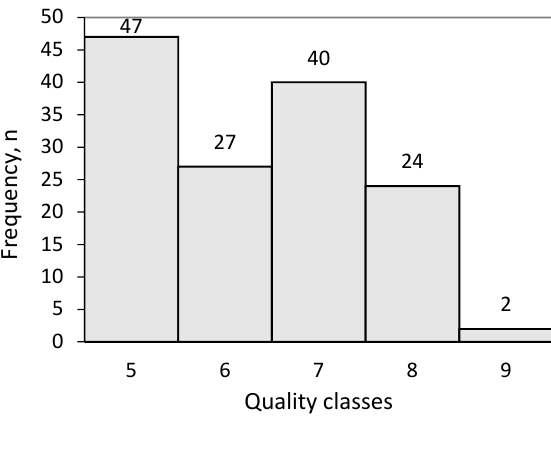
Figure 2. Reference tree quality distribution based on ocular assessment. Classes: (5) best-quality timber; (6) damaged good-quality timber; (7) timber; (8) damaged timber; and (9) low-quality timber